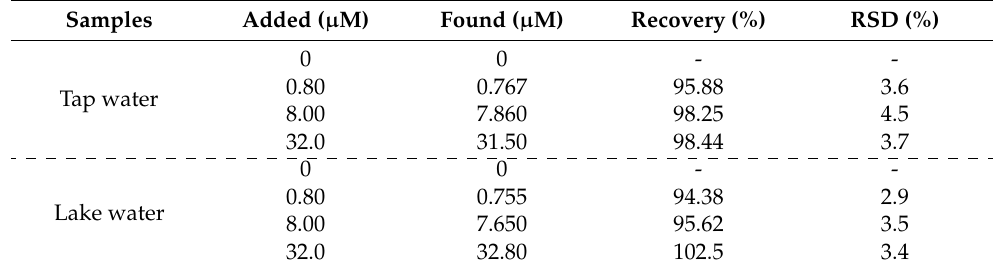
Table 2. Detection of H 2 O 2 in actual water samples. (n = 3).